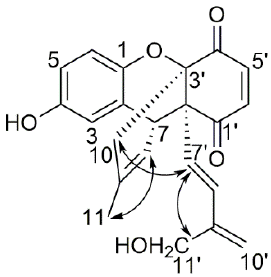
Figure 3. Selected NOESY correlations of ehretiquinone B ( 3 ).